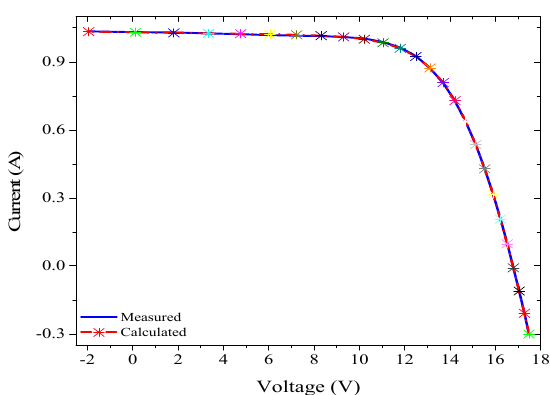
Figure 11. I–V curve of the measured and the calculated currents for the single-diode module. Energies 2020 , 13 , x FOR PEER REVIEW